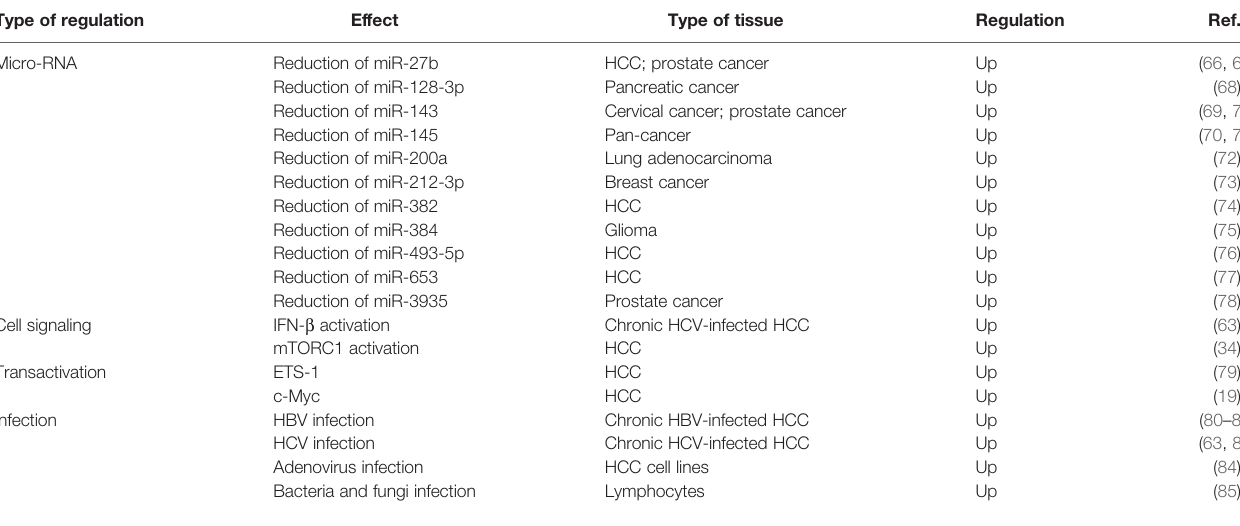
TABLE 2 | Transactivation and expression of GP73 in cancer